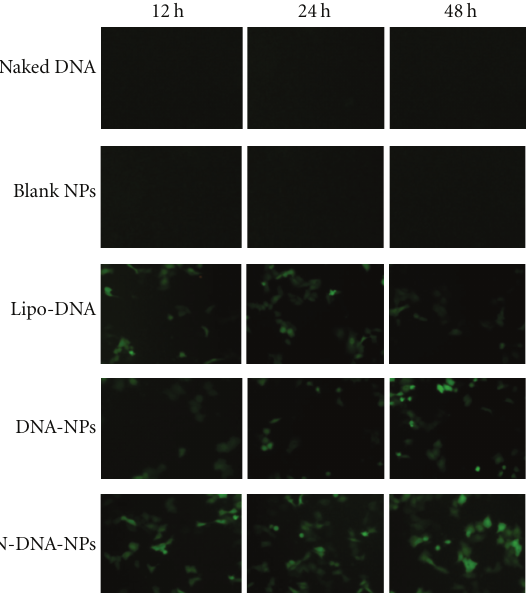
Figure 6: Fluorescent micrographs of KCs transfected by plasmid EGFP in vivo. Gene expression was examined after 12, 24 and 48 h post